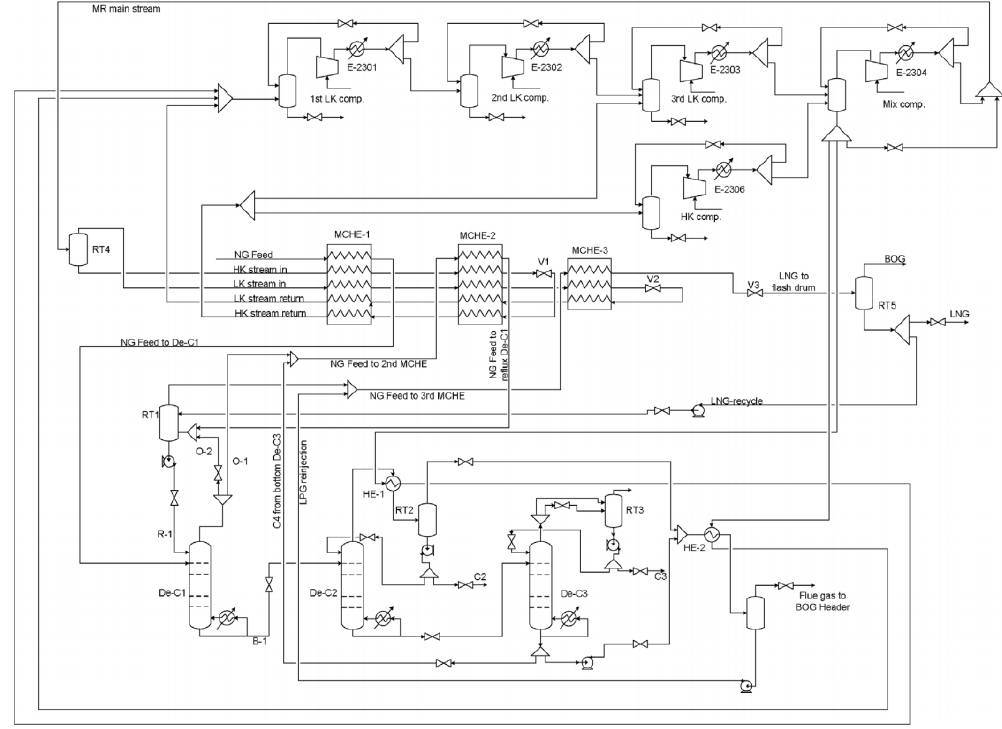
Figure 31. Conceptual structure of MSMR process [111]. Reproduced with permission from Elsevier (license number 5413460811174).